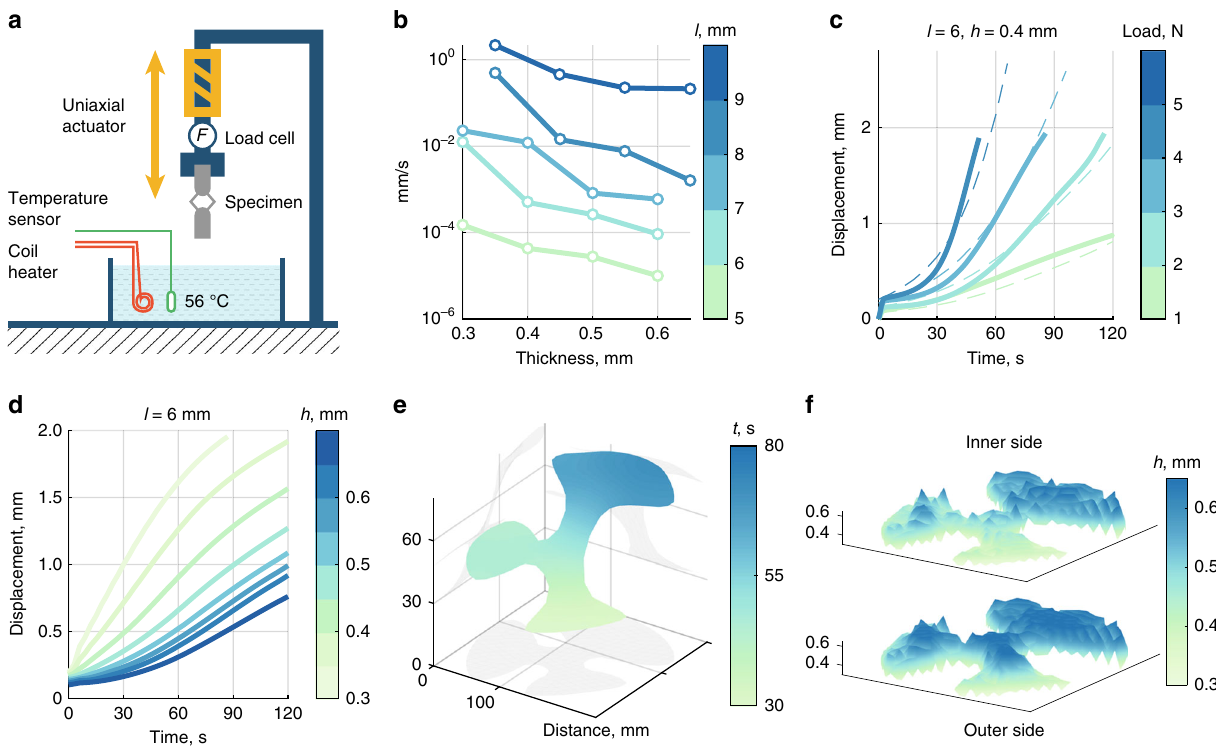
Fig. 2 From measurement of brackets ’ mechanical properties to inverse design of temporal morphing. a Load-controlled tensile tests were used to determine the deformation rates of unit cells in 56 (cid:3) C water. b Average deformation rates for specimens subject to constant loads of 4 N for l < 7 and 5 N for l (cid:4) 7 N. These values are close to the inner membrane tractions on each unit cell in real shells. c Deformation rate measurements (solid lines) are fi t (dashed lines) to produce a model of bracket softening. Here we show the fi t for l = 6 mm, h = 0.4 mm. d The model is interpolated and queried to infer the mesostructure that yields target curvatures and deformation completion times in each section of the shell. Here, we show deformations of unit cells with central length l = 6 mm and a range of bracket thicknesses from 0.3 mm to 0.65 mm. e Smooth actuation time landscape that induces the sequential deformation process demonstrated in Fig. 1. f Bracket thickness fi elds for both sides of the petalled shape. Though the prescribed time landscape is smooth, the fi eld of bracket thickness is highly irregular because bracket thicknesses also depend on initial unit cell lengths and their target